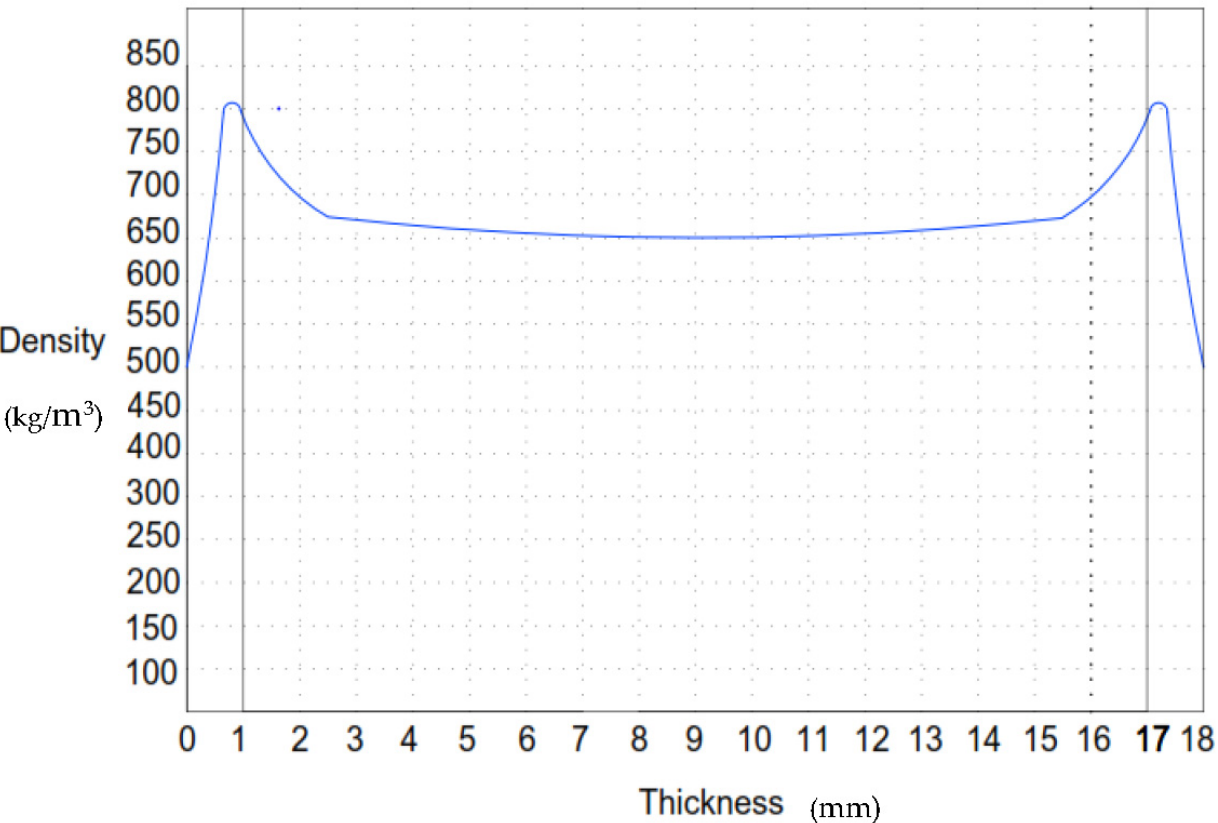
Figure 9. X-ray vertical density profile of 2 nd specimen. Table 11. Experimental data of 2 nd sample.